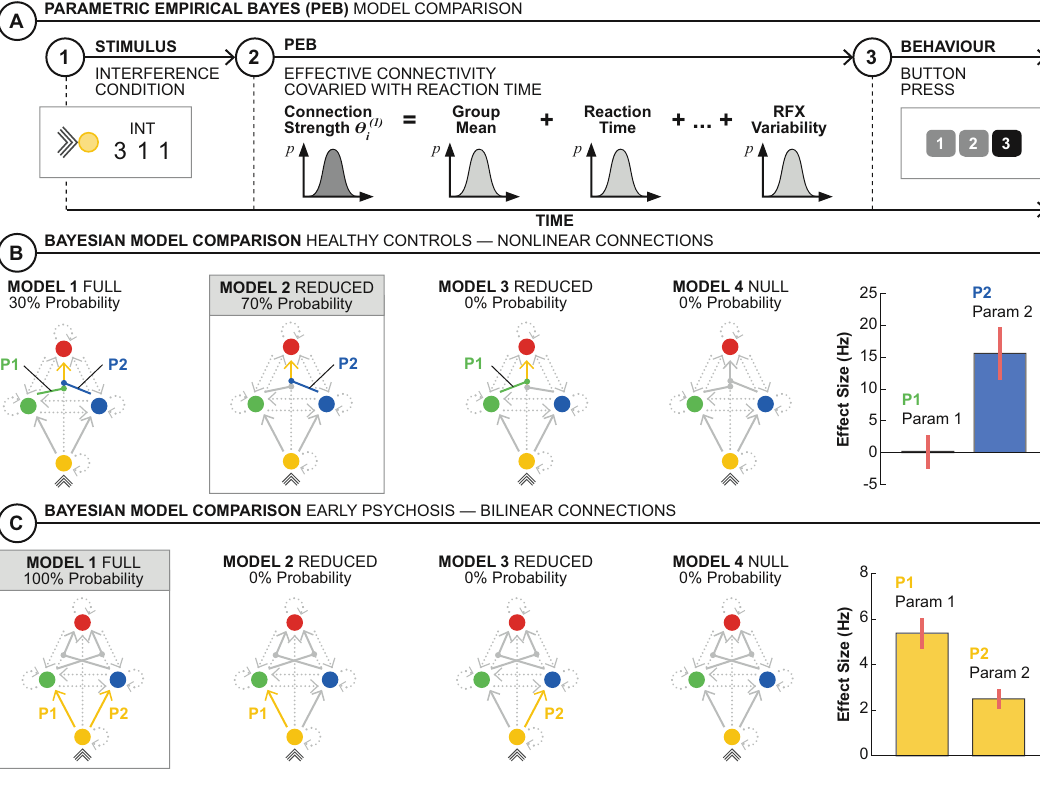
online Supplementary Table S6) and years of education ( t = − 3.1,